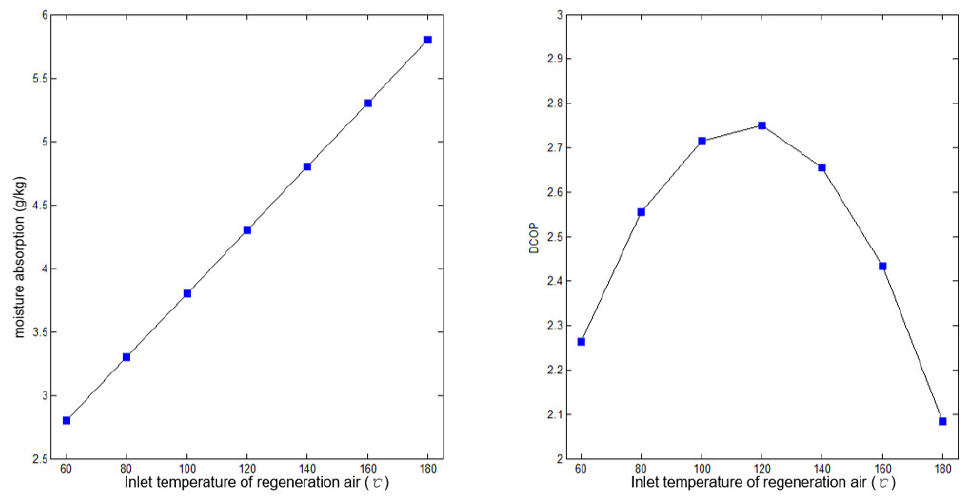
Figure 15. Effect of inlet temperature of regenerated air on hygroscopicity D and